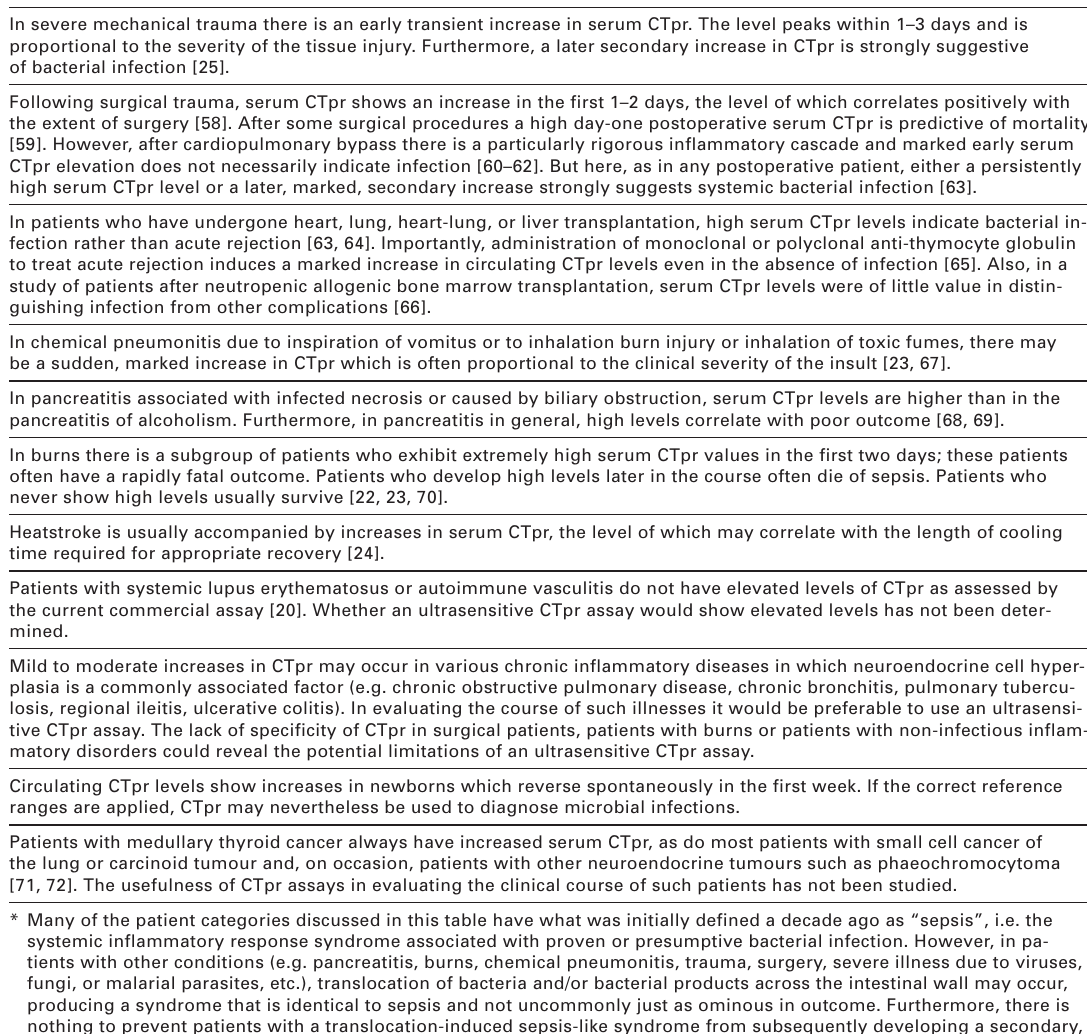
Patients with systemic fungus infections (e.g. candidiasis, aspergillosis) may have increased serum CTpr values [32]. However, some patients have slightly or moderately increased levels [33,